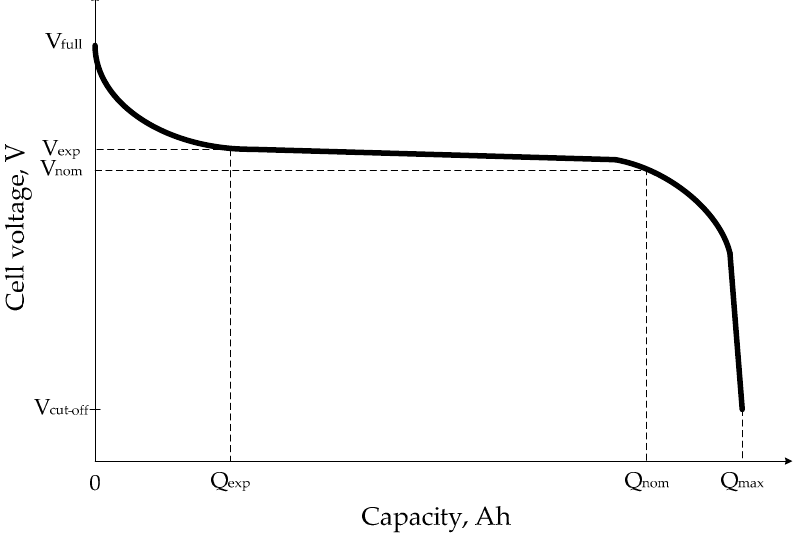
Figure 1. Typical discharge characteristic curve of Li ‐ ion battery [4,5].